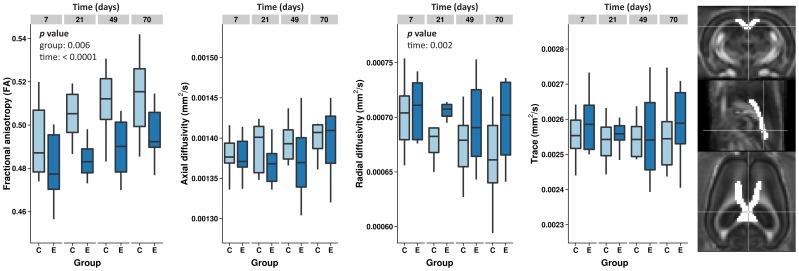
Corpus callosum diffusion tensor imaging measures.Fractional anisotropy (FA), axial and radial diffusivity, and ADCtrace values in the medial corpus callosum at each time point for the control and epilepsy groups. FA increased gradually in control animals. In epilepsy rats, this age-related increase was delayed and absolute values were lower. None of the other three parameters showed significant group or group × time interaction differences. The corpus callosum ROI is overlaid on the FA template (ROI in white; shown on slices in three orthogonal directions) (most right). Statistical significance obtained from the linear mixed model analysis is indicated for factor with p<0.05.